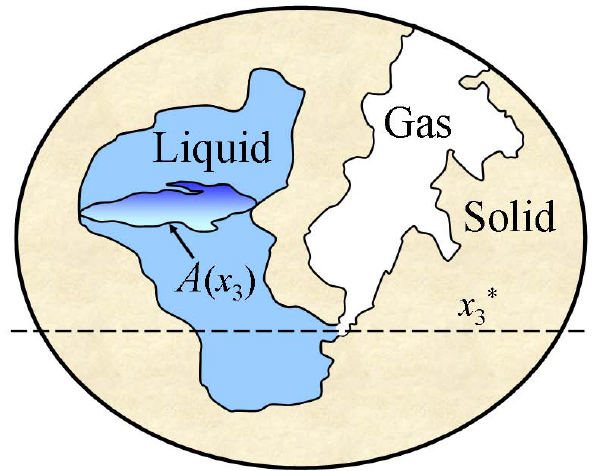
Fig. 1. A hypothetical liquid-filled pore with a single exit in which the liquid-gas interface is located at vertical position x ∗ izontal liquid-filled cross-section A at arbitrary elevation x 3 is also